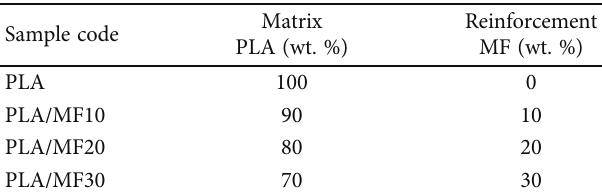
Table 1: Formulation of PLA/MF composites.